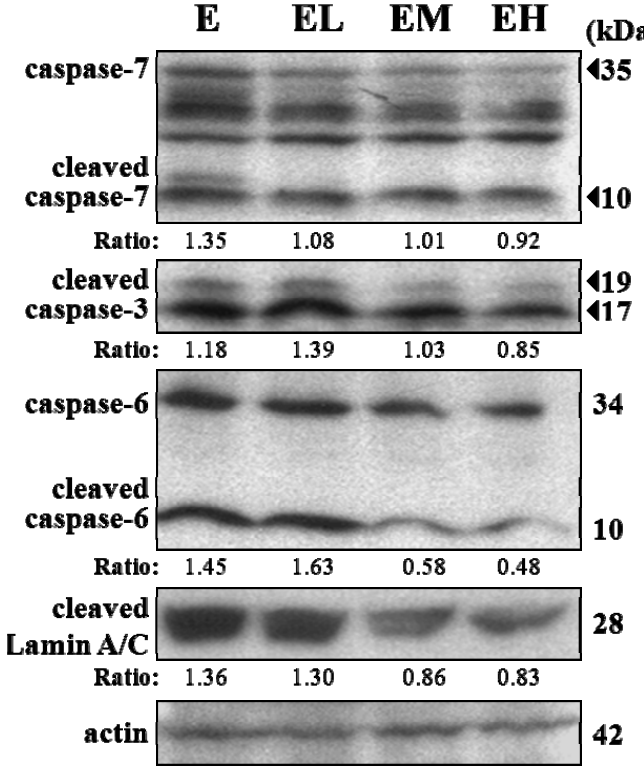
Figure 3. G. tsugae supplement effect on caspases-mediated apoptosis pathway in liver tissues after exhaustive exercise. Male SD rats were pre-treated with 0, 0.1875, 0.9375, and 1.875 g/kg of G. tsugae (E, EL, EM and EH) for 30 days and subjected to exhaustive treadmill exercise. For western blotting in liver samples, a pooled sample of rat liver proteins ( n = 6) in each group was loaded on each gel and underwent immunoblotting.